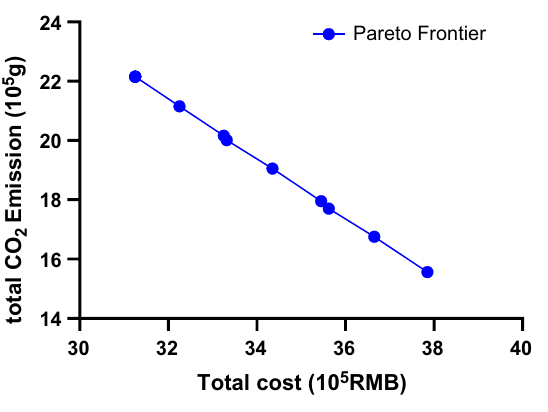
Figure 3. Pareto frontier of the proposed